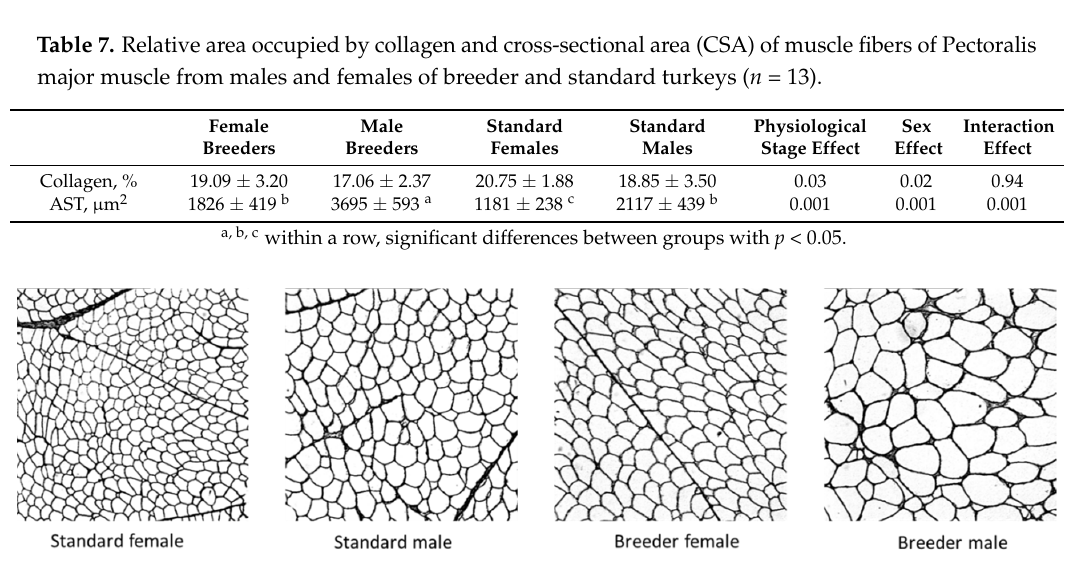
Figure 2. Relation between CSA of muscle fibers and breast weight from males and females of breeder and standard turkeys ( n = 13). 4. Discussion 4.1. Sex Effect The turkey is characterized by a strong sexual dimorphism on body weight resulting in a higher weight of carcass and cut pieces for males compared to females. It was the same for the yields expressed relative to body weight. The coefficient multiplier between the breast weight of male breeders and that of female breeders was 3.48. For the CSA of muscle fibers of PM muscle, this coefficient was 2.02. For the standard turkeys, these coefficients were 2.43 and 1.79, respectively. This means that the breast weight difference between males and females was partially due to the hypertrophy of the muscle fibers but also due to a more important number and/or length of muscle fibers. Concerning the technological quality, males slaughtered at older ages presented a lower pHu in PM and IT muscles than that measured for females, suggesting higher glycogen reserves [41]. The PM and IT muscles of males had higher haeminic pigment content and they were redder than those of females. The males had PM muscles displaying higher drip loss during a storage at 4 °C and higher cooking loss, resulting in a lower technological yield than that of females [41]. On the other hand, the protein oxidation in SART muscle during a storage at 4 °C was lower for males compared to females.